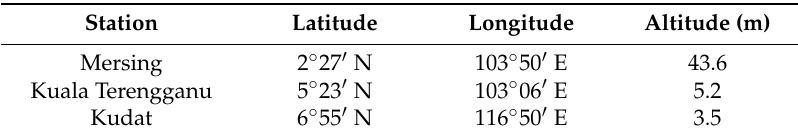
Table 1. Description of the measured wind speed stations in regions in Malaysia.